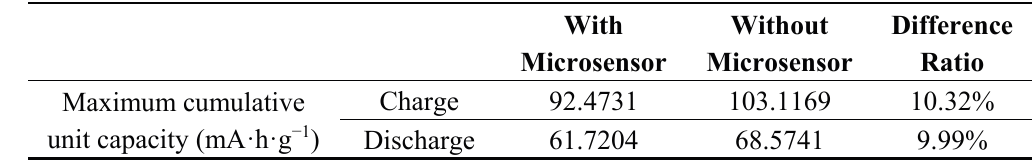
Table 7. Comparison of performance of lithium batteries with and without embedded three-in-one microsensors.